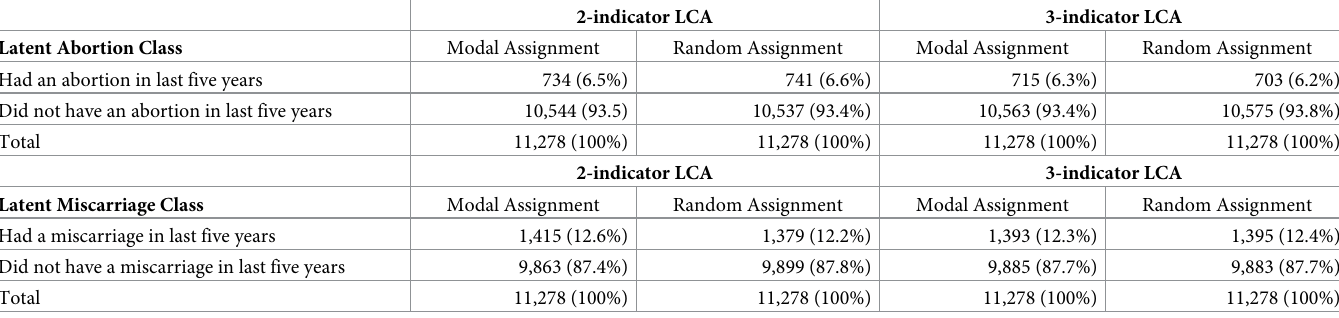
Table 2. Predicted latent abortion and miscarriage classes